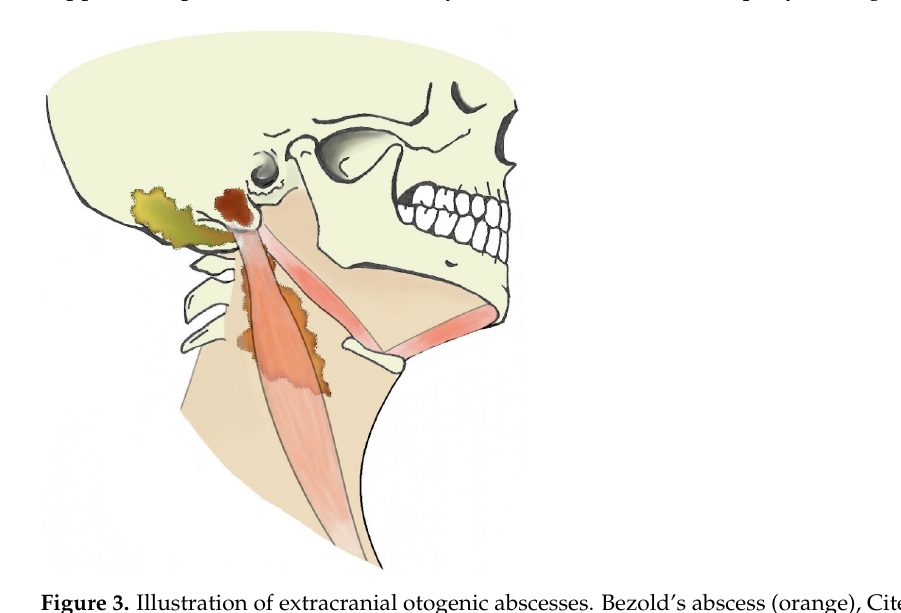
Figure 3. Illustration of extracranial otogenic abscesses. Bezold’s abscess (orange), Citelli’s abscess (yellow), subperiosteal empyema (brown).